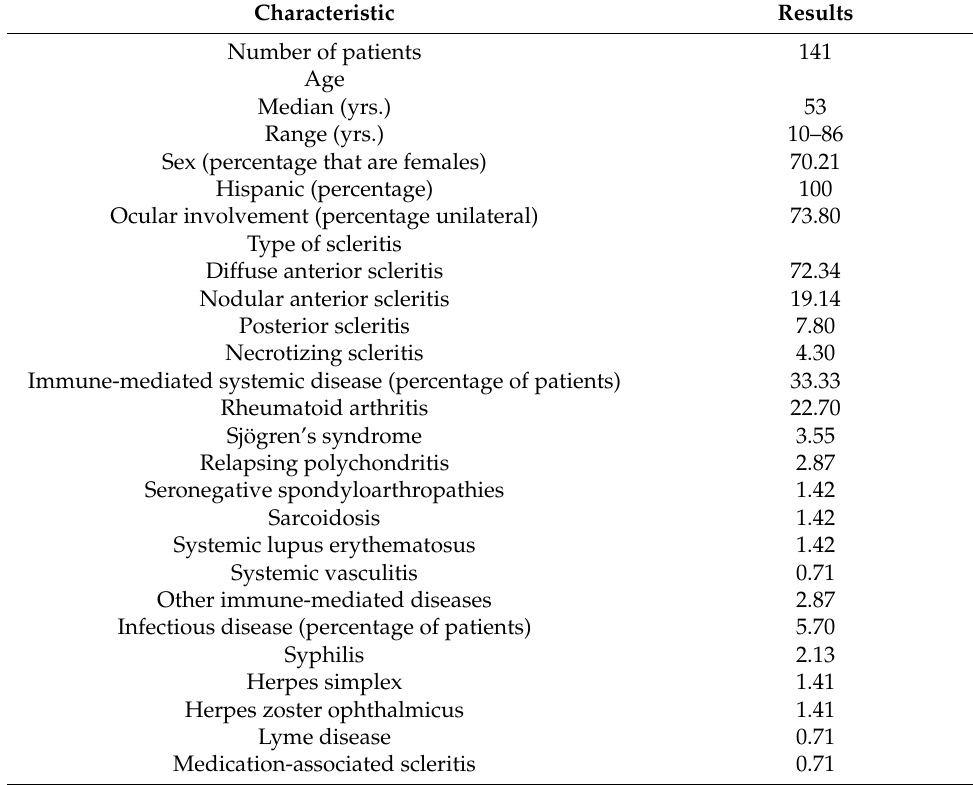
Table 1. Characteristics of the patients with scleritis at